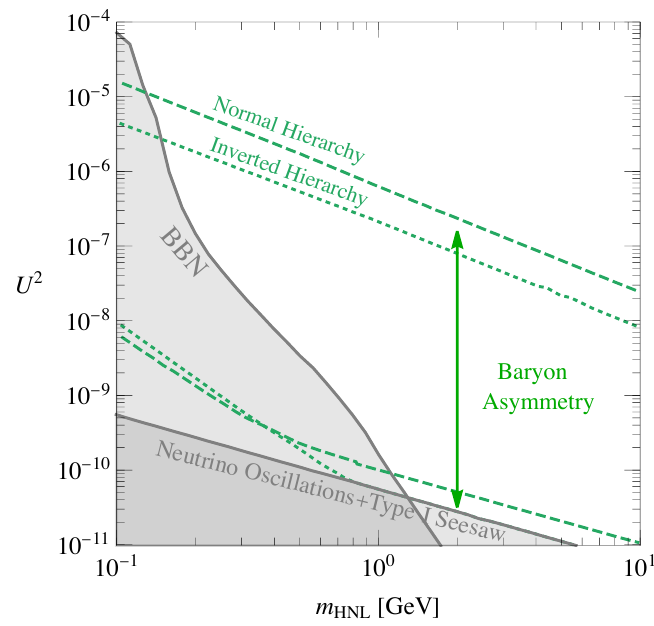
Figure 4 . The target parameter space in a scenario of two degenerate HNLs with respect to the HNL mass and the sum of the mixing squared defined in eq. (4.3). The region between dashed (dotted) green lines is favored as the HNL can generate the baryon asymmetry of the universe [11, 12], and the lines are adopted from figure 4.17 of [8]. The bottom shaded region cannot explain the neutrino oscillation data in Type-I seesaw mechanism with the two degenerate HNLs. Another shaded region with the BBN label is excluded by that the long-lived HNLs affect the successful big bang nucleosynthesis. The bound is obtained with respect to U , U , or U in [30], and we take e µ τ U 2 < min ‘ = e,µ,τ [ | U (BBN) | 2 ] for this ‘